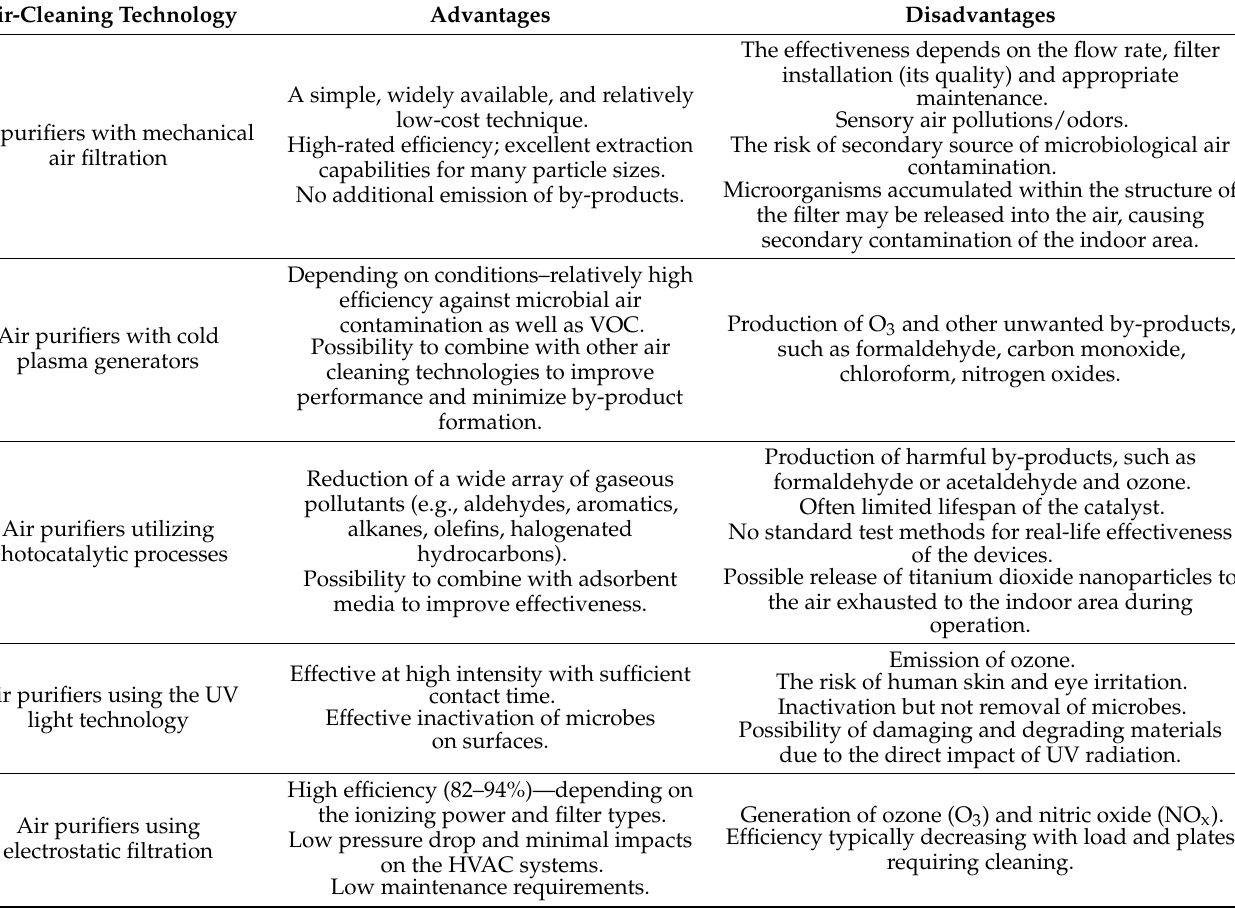
Table 1. The summary of the advantages and disadvantages of air-cleaning